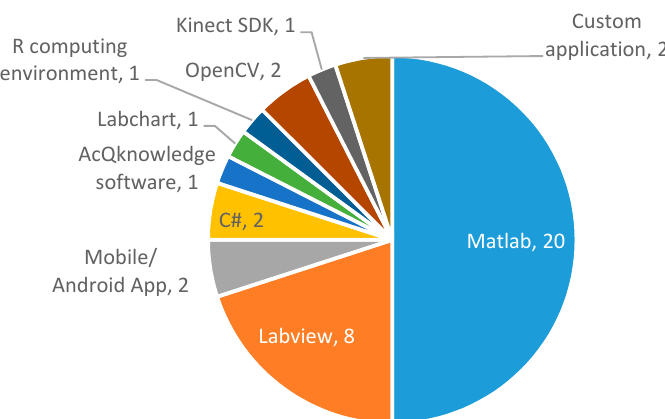
Figure 36. Number of studies using the di ff erent processing tools for the wearable ( top ) and environmental ( bottom ) categories.